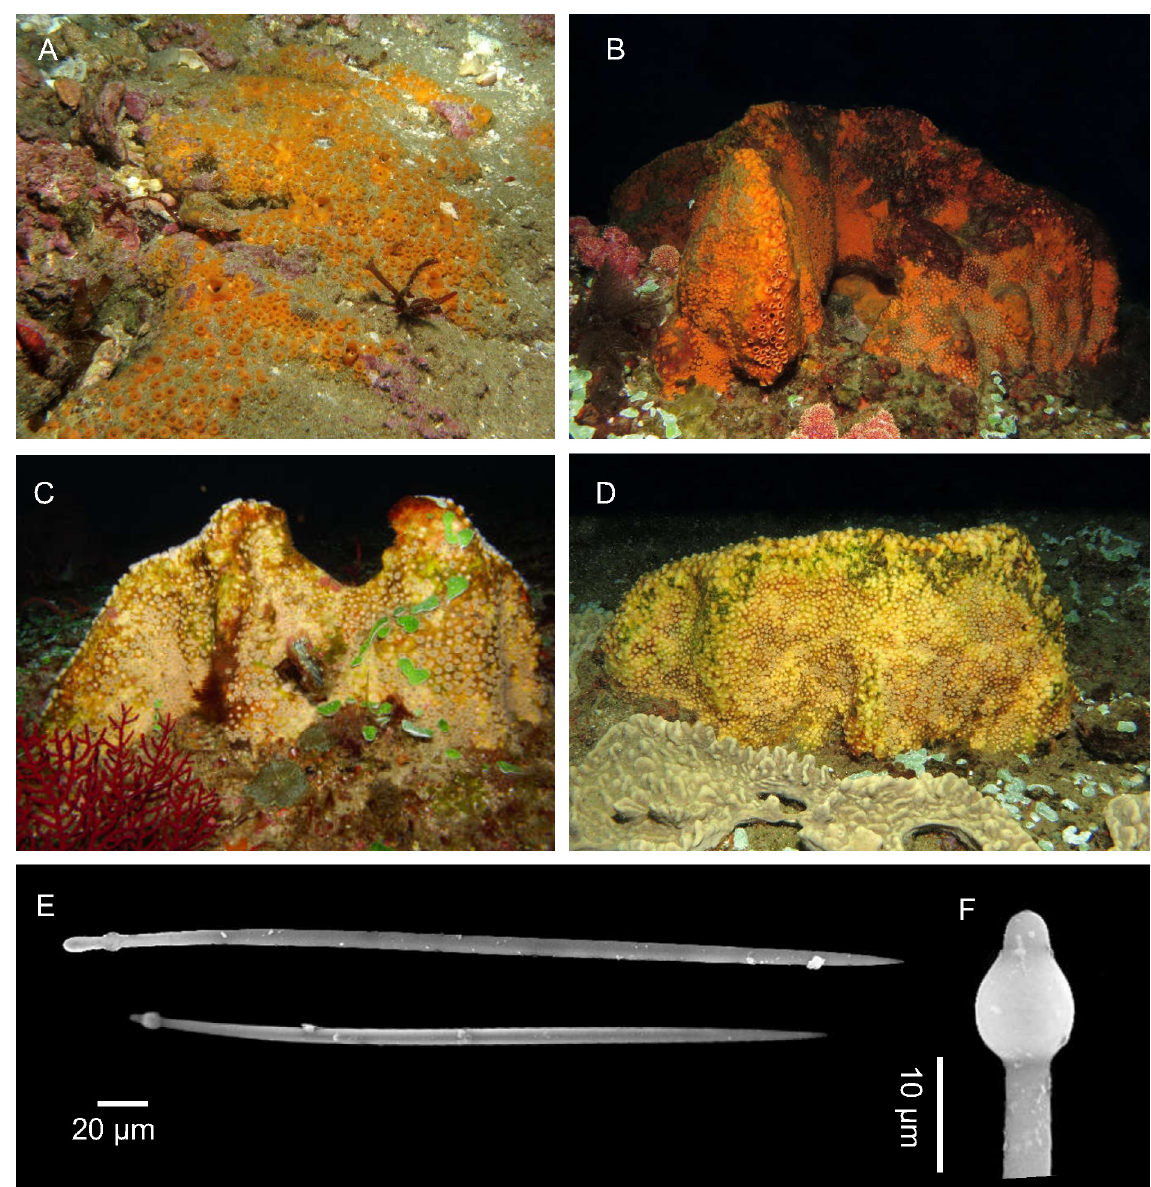
Fig. 15. Cliona grandis Samaai et al. , 2019. A . Sponge in encrusting stage (β), PO64. B–D . Sponges in massive stage (γ), respectively PO22, IMG830 and PO27. E . Tylostyles. F . Magnification of the tylostyle